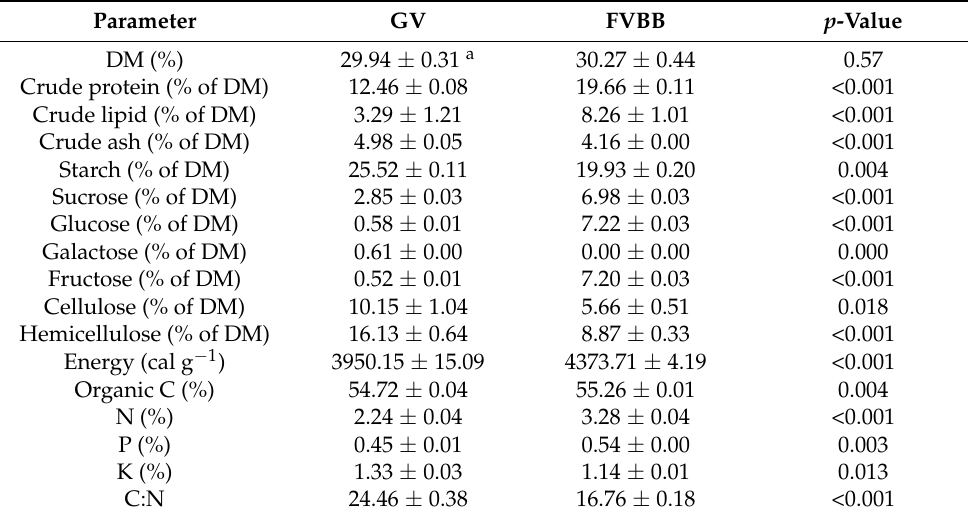
Table 1. Chemical composition of the Gainesville (GV) and the fruit/vegetable/bakery/brewery (FVBB)